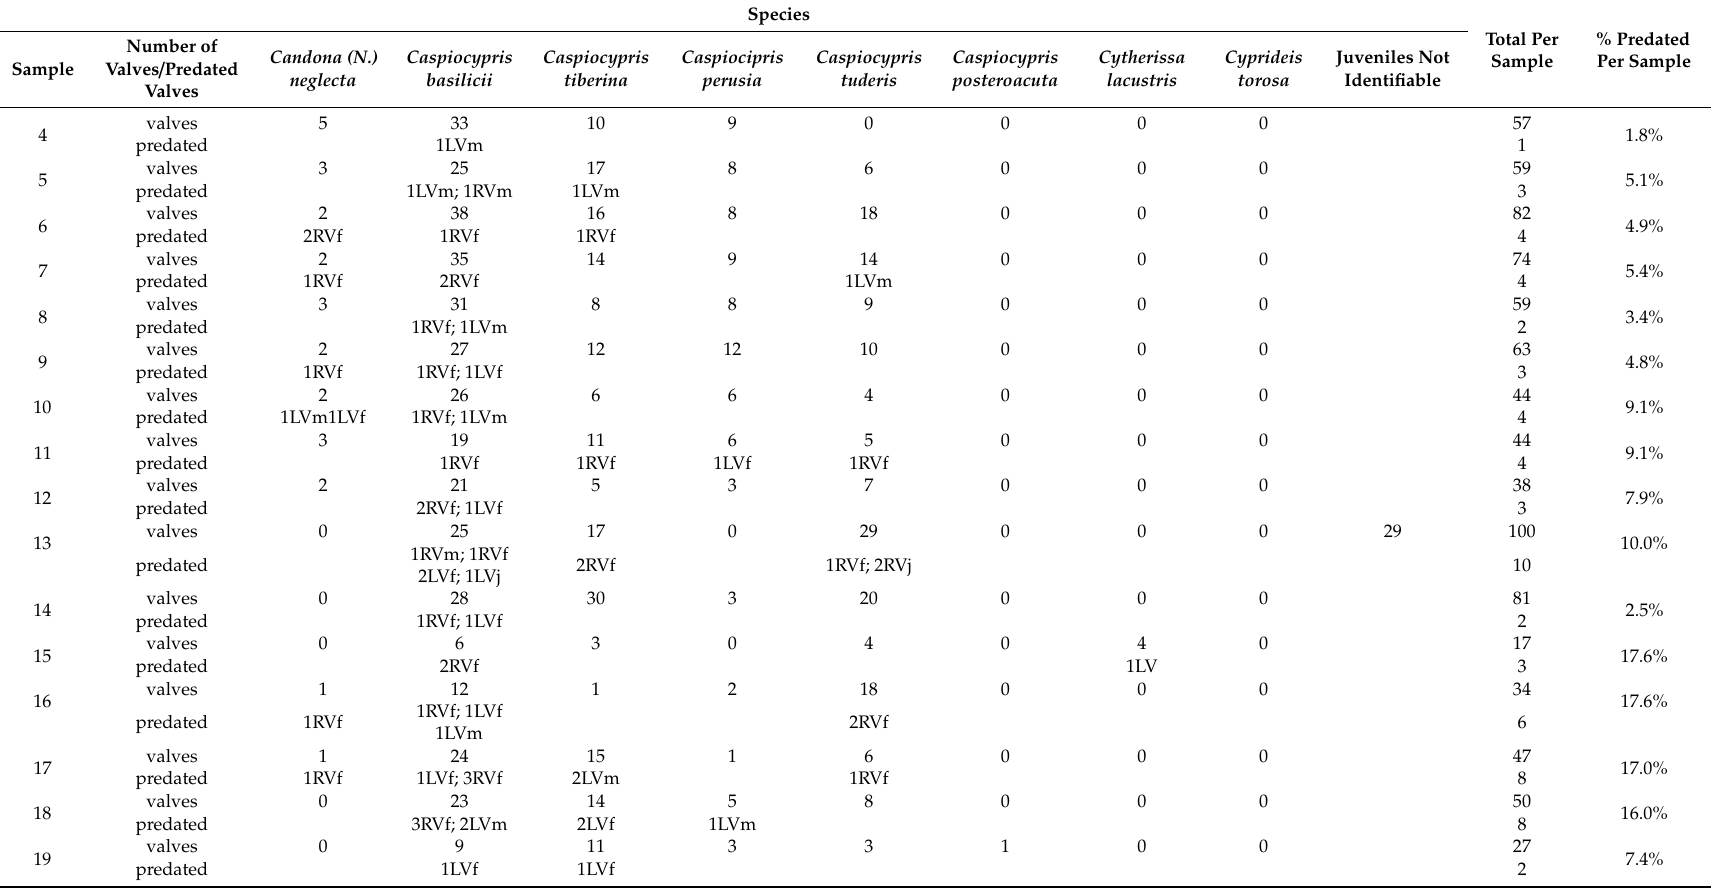
Table 1. Ostracods of Cava Nuova, taxa recovered in assemblages and typology of predate valves. LV = left valve; RV = right valve; m = male; f = female; j =